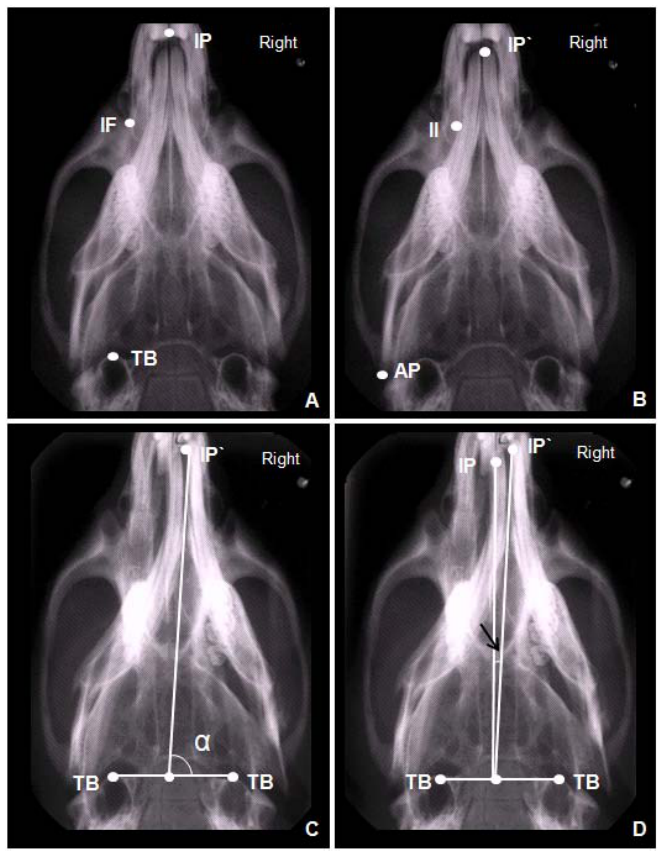
FIGURE 1 – Axial radiographs and cephalometric reference points. A. Skull; TB = tympanic bulla, IF = infraorbital foramen and IP = upper incisal point. B. Mandible; AP = angular process, II = insertion of incisor e IP´ = lower incisal point. C. Measurement of angle α . D. Arrow = measurement of angle Â.